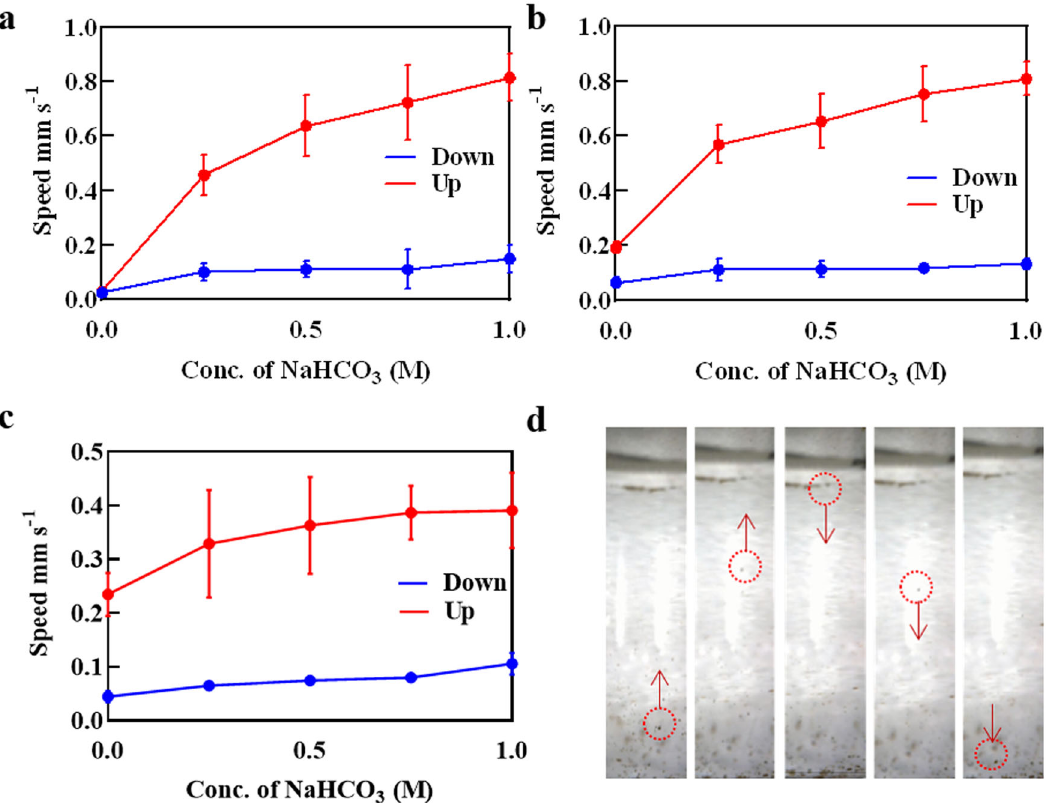
Fig. 3 Propulsion kinetics of MFN. Analysis of upward and downward propulsion speed of the nanobot in: a PBS, b DMEM, c serum, d time-lapse images of nanobot in 0.5 M NaHCO 3 solution in